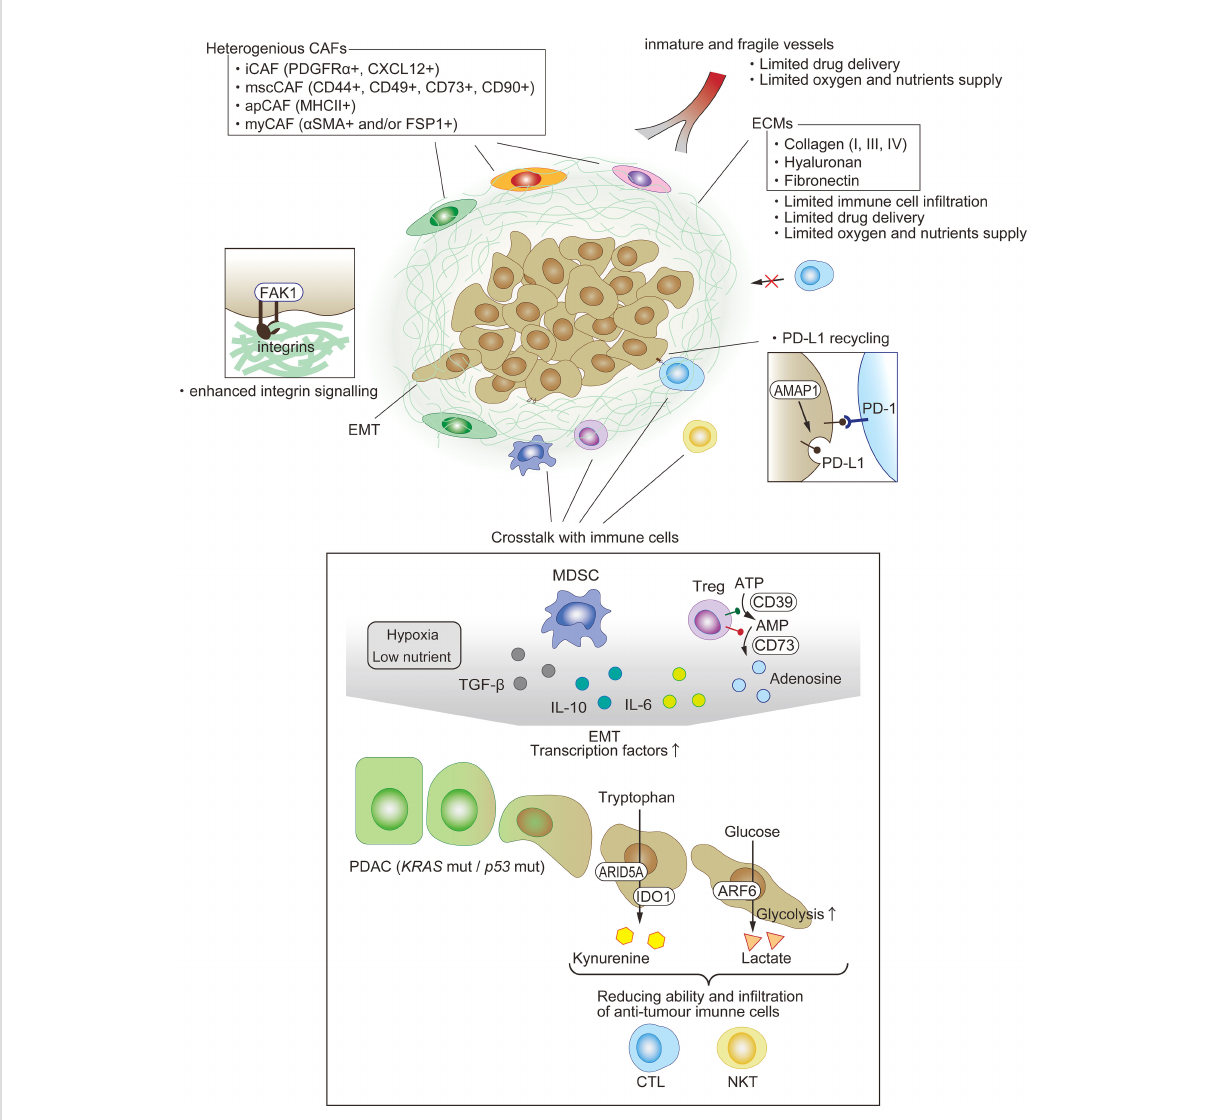
FIGURE 3 Immunosuppressive TME in PDAC. One of the features of PDAC is dense fi brosis, which limits immune-cell fi ltration, drug delivery, and oxygen supply. A variety of cells exist and compose the immunosuppressive milieu. Each type of fi broblast appears to play a key pro-tumor or anti- tumor role. The EMT of PDAC is among the factors enhancing anti-tumor immunity through not just cell intrinsic functions, such as PD-L1 recycling, but also crosstalk with other immune